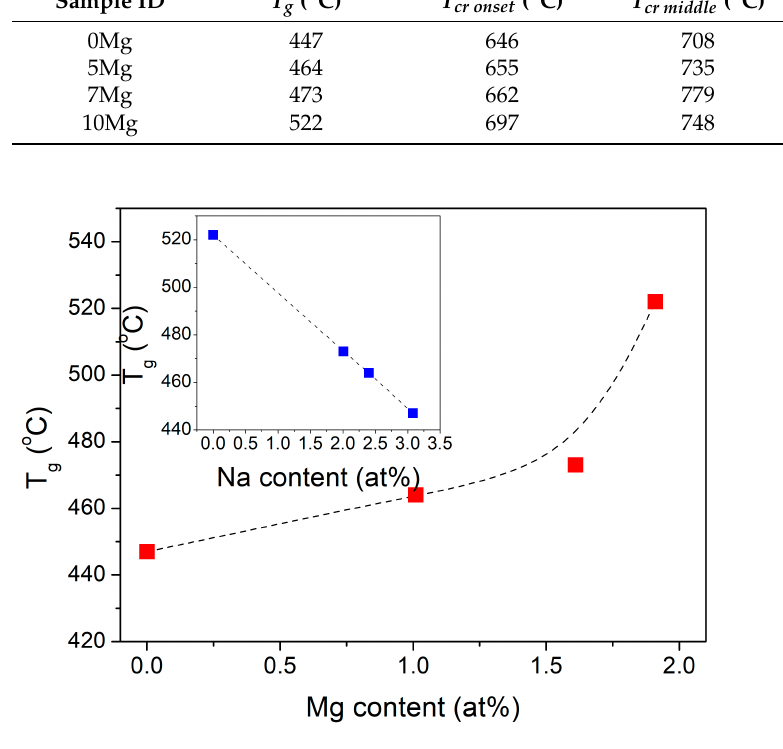
Figure 11. T g as a function of Mg content and in insert function of Na content. The experimental errors are about the same size as the symbols. Table 4. DTA results of experimentally analyzed samples; glass transition ( T g ), exothermic process onset ( T cr onset ), crystalline peak position ( T cr middle ), and glass stability ( S).